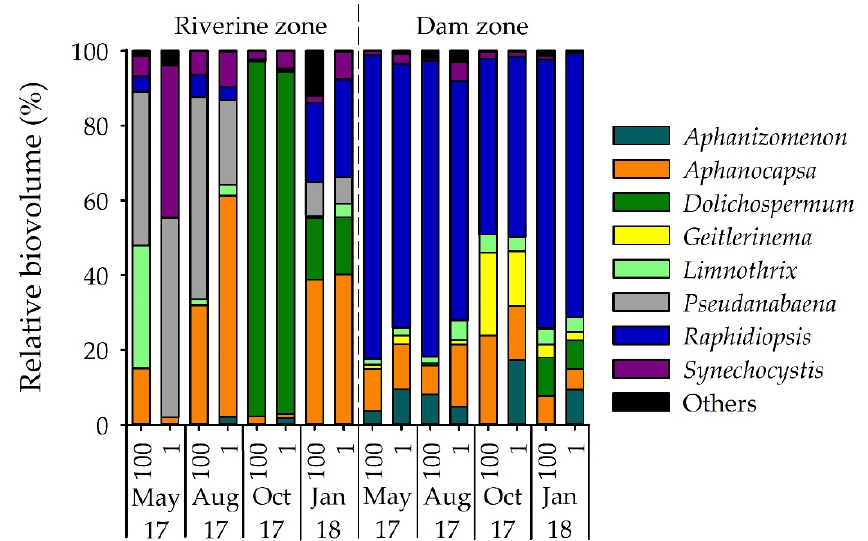
Figure 3. Relative biovolume (%) of cyanobacterial genera identified in Itupararanga reservoir. Others = Aphanothece , Chroococcus , Cuspidothrix , Merismopedia , Microcystis , Phormidium , Glaucospira and Limnococcus ; 100 = surface; 1 = lower limit of euphotic zone.